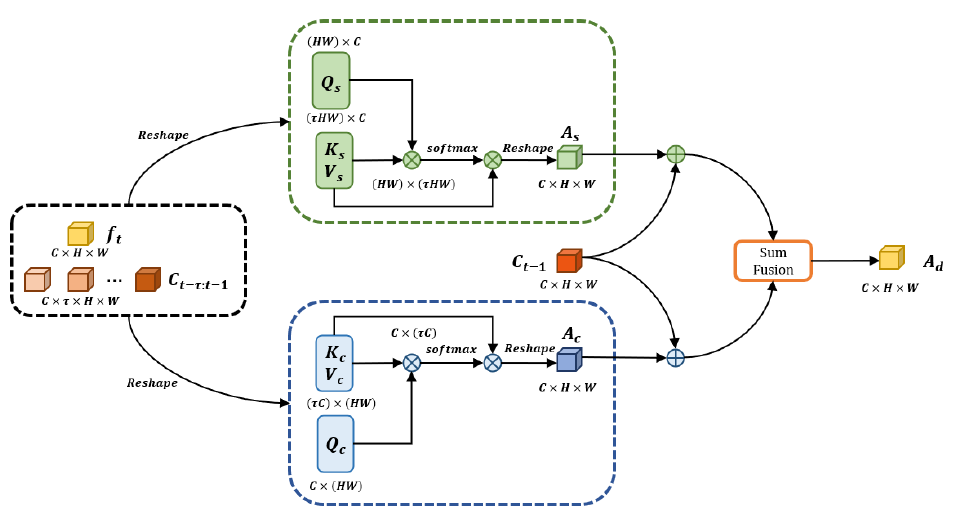
Figure 4. The dual attention mechanism embeding in proposed model. Channel Attention Module aims to model the correlations between the channels.